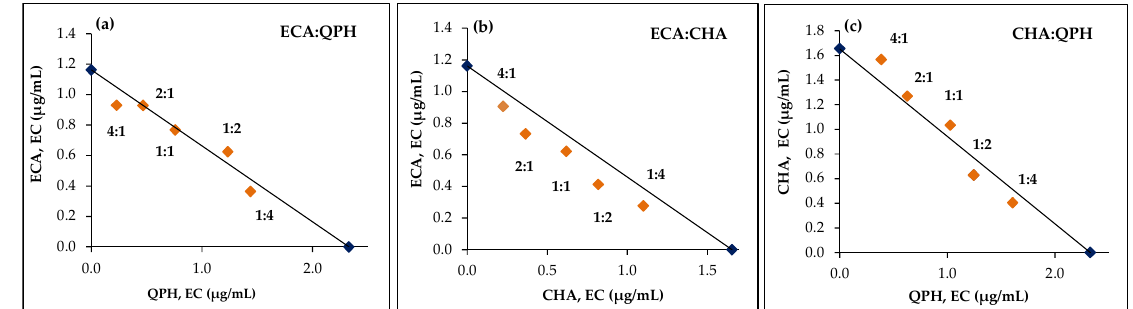
Figure 5. E ff ective concentration (EC) isobologram for the interactions between ( a ) ECA and QPH; ( b ) ECA and CHA; ( c ) CHA and QPH in the chemical FRAP model. The straight line is an estimated isobole for an additive interaction between two substances based on the EC of pure phenolics (dark blue datapoints). The orange datapoints represent the experimental EC values for combinations of the investigated analytes. The EC parameter indicates the concentration of an analyte required for a reduction in 34 µ M of Fe 3 + in the conditions of the